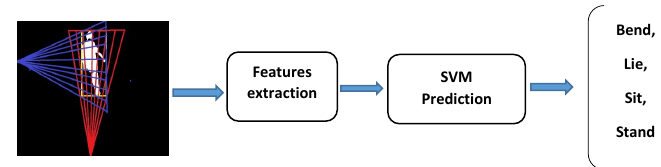
Figure 6. Posture